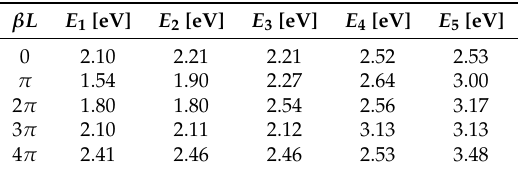
sin ( β s − ψ 0 ) , α = 0.5, ψ 0 = 0. 2